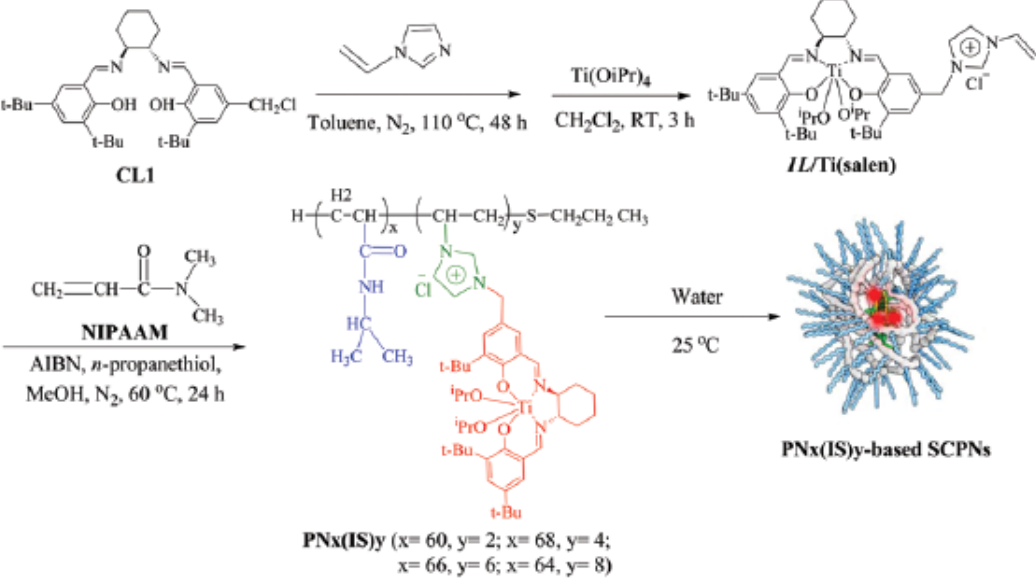
Figure 11. Formation via self-folding in water of poly( N -isopropyl acrylamide)-based SCNPs containing a chiral salen Ti IV complex in the core for asymmetric sulfoxidation in water of alkyl phenyl sulfides (reprinted from [52] with permission, Copyright Royal Society of Chemistry, 2017). CL1 = ( R,R )- N -(3,5-di-tert-butylsalicylidene)- N ′-(3-tert-butyl-5-chloromethyl-salicylidene)-1,2-cyclohexane diamine; IL /Ti(salen) = vinyl imidazolium ionic liquid-modified chiral salen Ti IV complex; NIPAAM = N -isopropylacrylamide; AIBN = azobisisobutyro-nitrile.